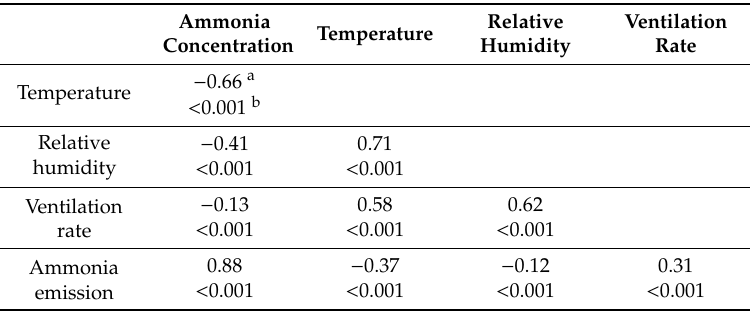
Table 5. Results of correlation analyses (Spearman’s rho) of hourly ammonia concentration, temperature, relative humidity, ventilation rate, and ammonia emission.